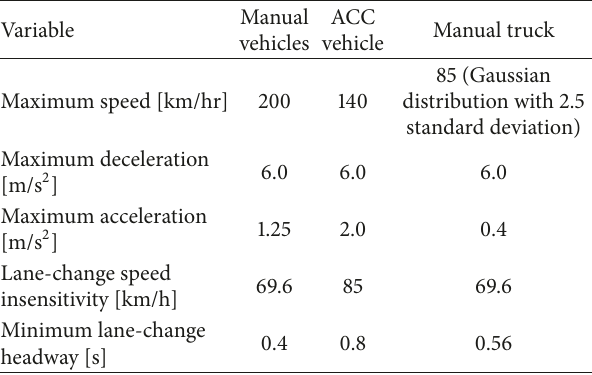
Table 2: Other relevant vehicles settings used in the